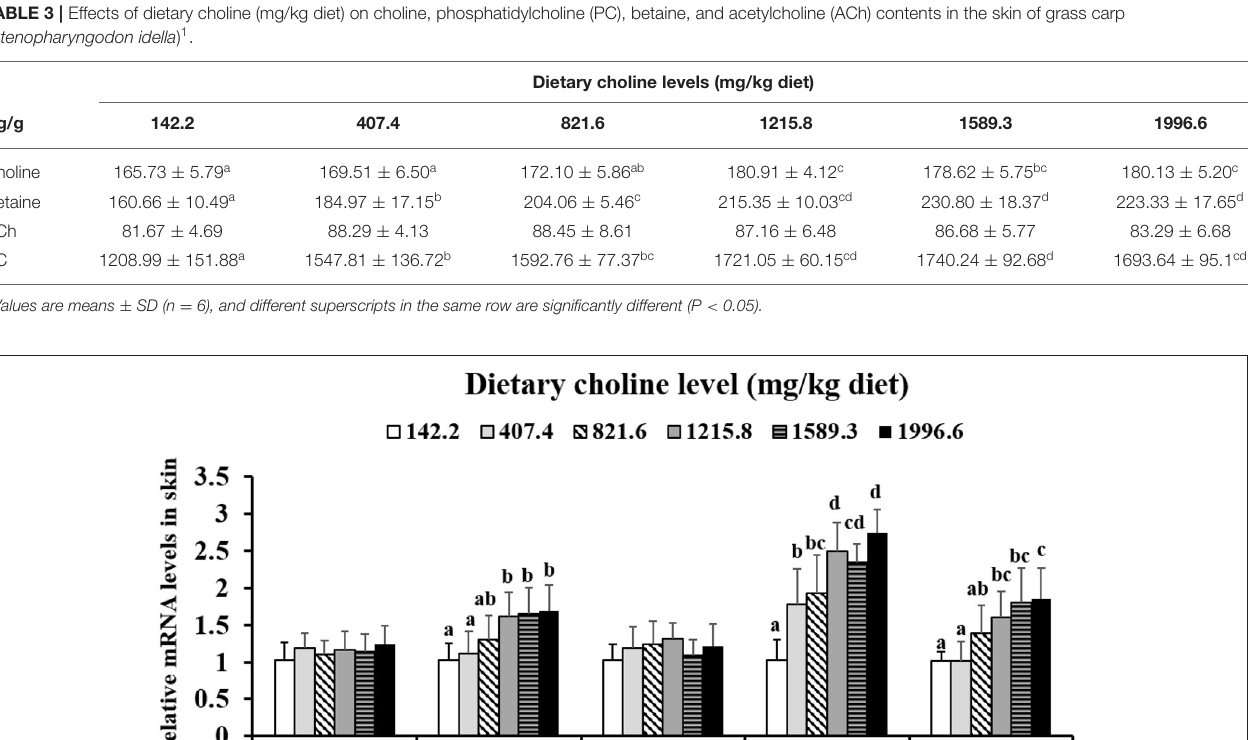
TABLE 3 | Effects of dietary choline (mg/kg diet) on choline, phosphatidylcholine (PC), betaine, and acetylcholine (ACh) contents in the skin of grass carp ( Ctenopharyngodon idella ) 1 .